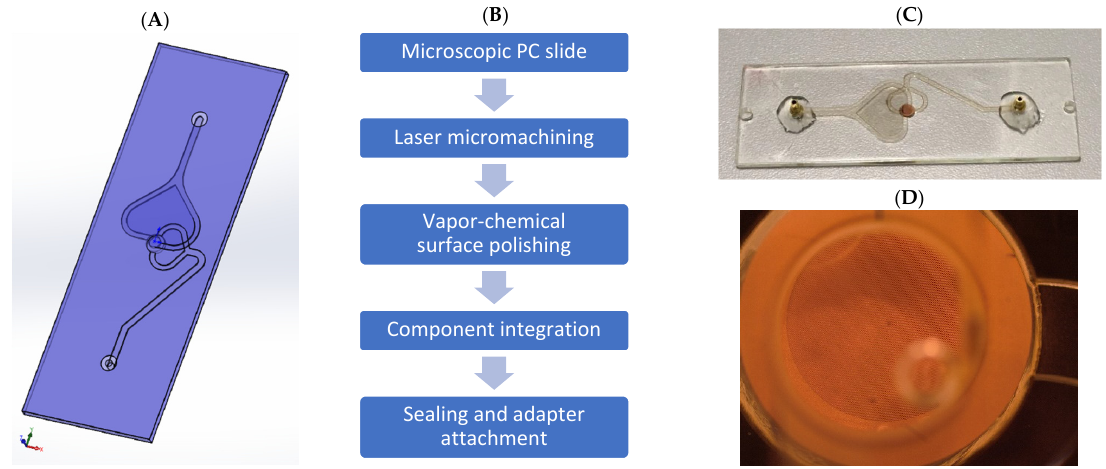
Figure 2. Design and fabrication steps of the cell capture device. ( A ) CAD design of a microscopic PC slide. Coordinates for laser micromachining were imported from STEP file. ( B ) Fabrication steps for PC slide to obtain cell capture device. The CAD design was machined into a PC slide through laser ablation. After vapor-chemical surface polishing and smoothing, the filtration component was integrated using an adhesive. After sealing of the microfluidic structures through sealing foil and adaption of tube adapters, the slide was ready to use. ( C ) Fabricated PC slide as cell capture device with integrated TEM-grid as filtration component. ( D ) Microscopic image of mounted TEM-grid.